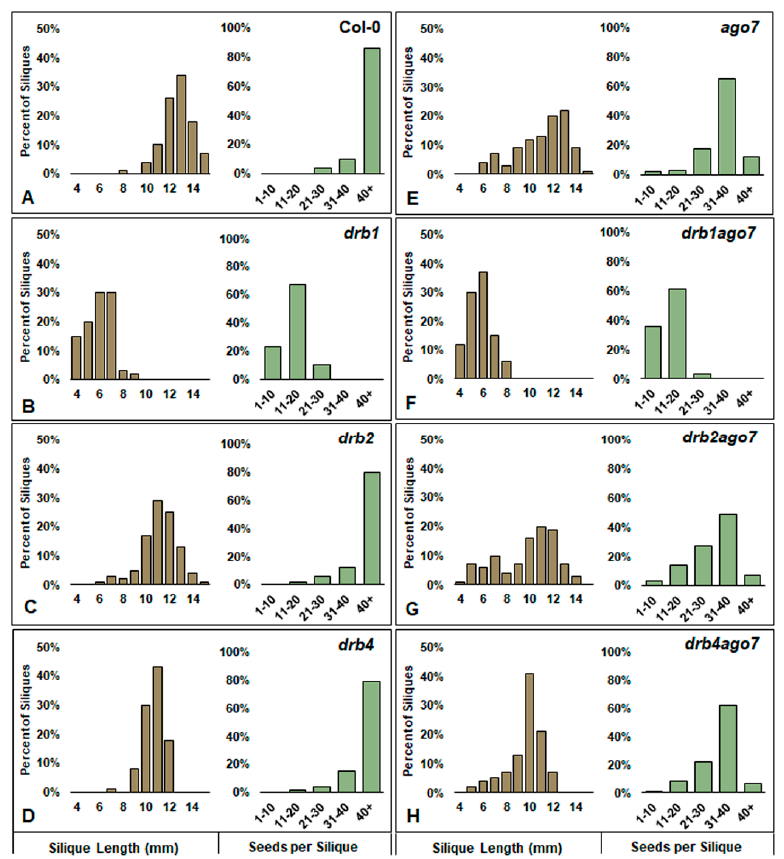
Figure 2. Quantification of silique length and the number of seeds per silique. ( A – H ) assessment of silique length, and the number of seeds harbored by each silique, with siliques harvested from along the entire length of the primary inflorescence of 42-day old ( A ) Col-0, ( B ) drb1 , ( C ) drb2 , ( D ) drb4 , ( E ) ago7 , ( F ) drb1ago7 , ( G ) drb2ago7 , and ( H ) drb4ago7 plants.